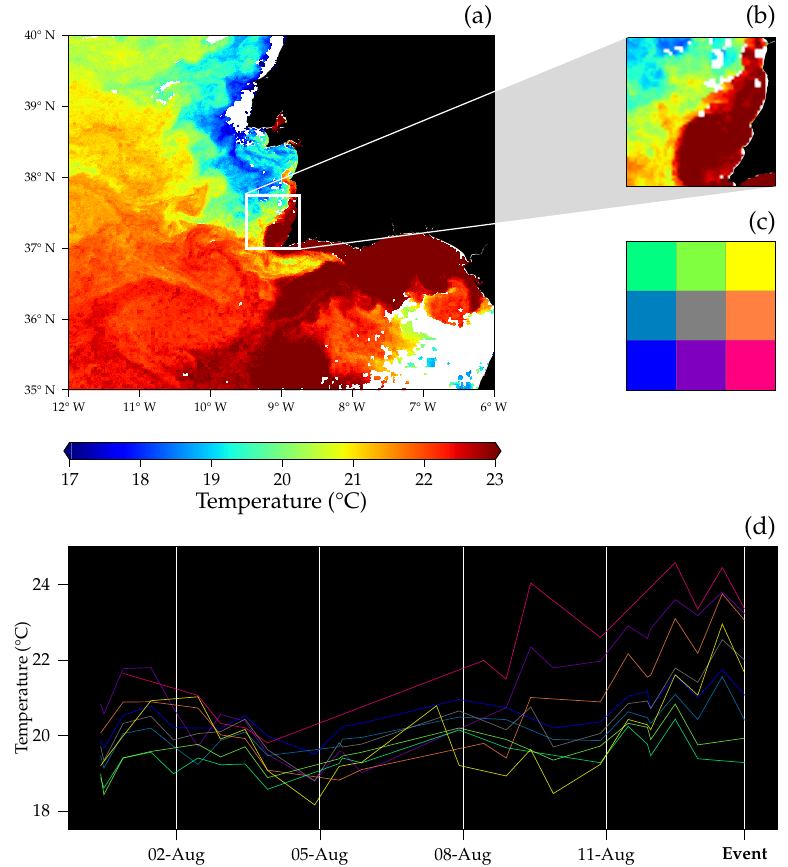
Figure 3. Event of 13 August 2016 at around 21:40 UTC. ( a ) SST map at the date of the event; ( b ) detail of the SST in the reference area for the spaghetti plot (latitude between 37° and 37.75° N, longitude between 9.5° and 8.75° W, resolution 0.25°); ( c ) reference grid; and ( d ) generated spaghetti